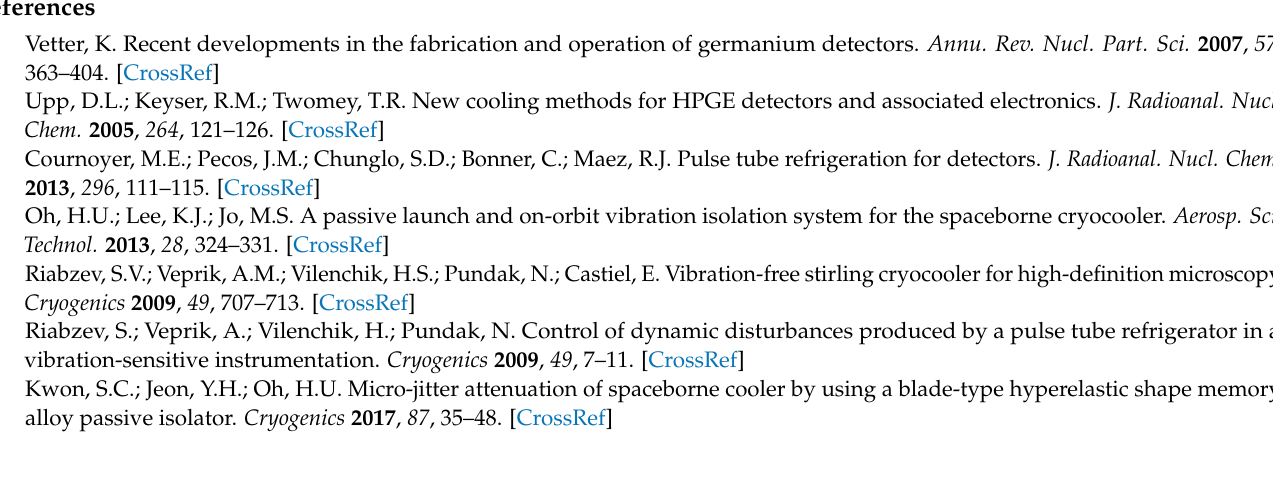
Figure 11. Co60 and Co57 energy resolution with PTC switched on.